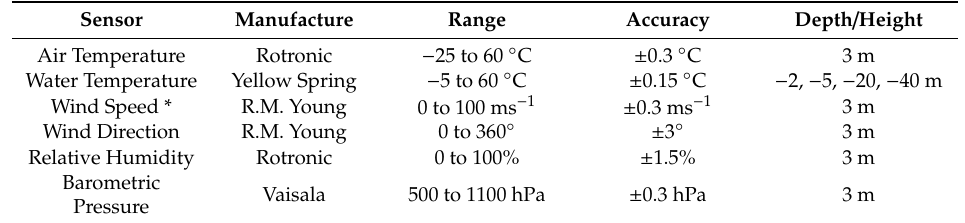
Table 1. Technical specifications of the sensors used in the SIMA buoy operating in the Serra da Mesa Reservoir. Adapted from Stech et al. [19].